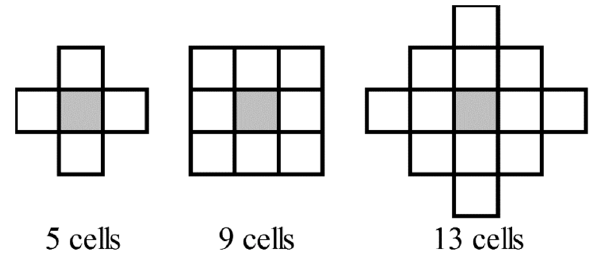
Figure 2. Pixel studied neighborhood for the variable H_STD5, H_STD9 and H_STD13.